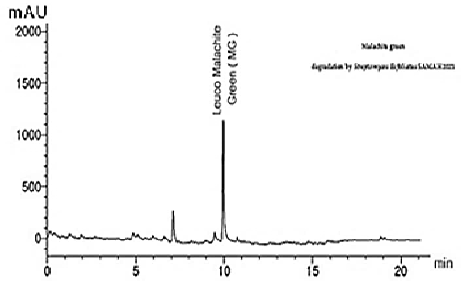
Figure 11. HPLC chromatogram of MG dye and its degraded metabolite products.